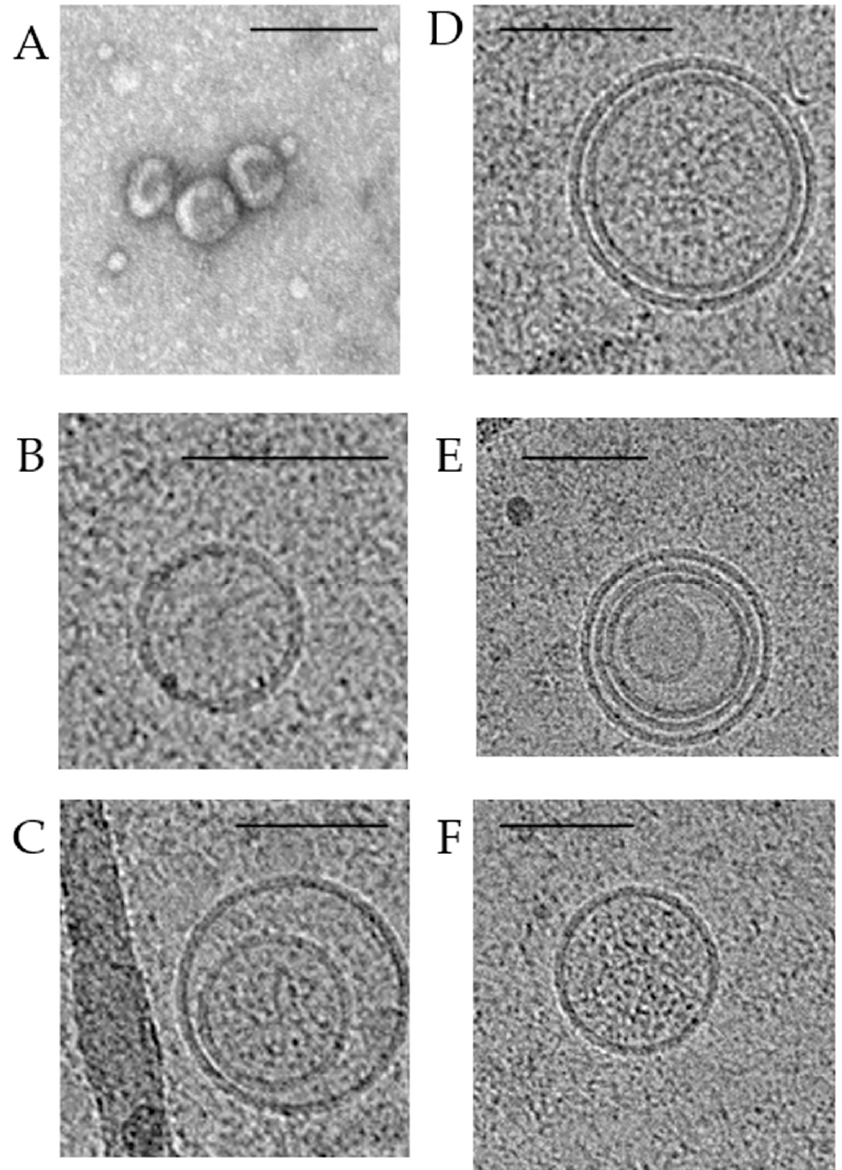
Figure 3. Transmission and cryo-electron microscopy images of exosomes isolated from pooled samples of BC patients’ plasma. Typical transmission electron microscopy view of exosomes ( A ). Cryo-electron microscopy images of exosomes: single vesicles ( B ); double vesicles ( C ); double-membrane vesicles ( D ); multilayer vesicles ( E ); vesicles with electron dense cargo in lumen ( F ). Scale bars are 100 nm.